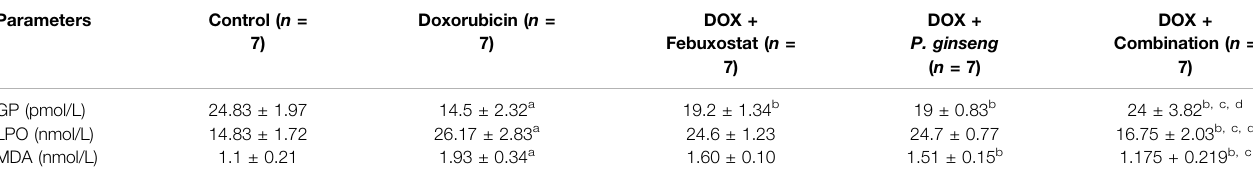
TABLE 1 | Effects of P. ginseng and Febuxostat on oxidative stress biomarkers in DOX-induced cardiotoxicity. Parameters